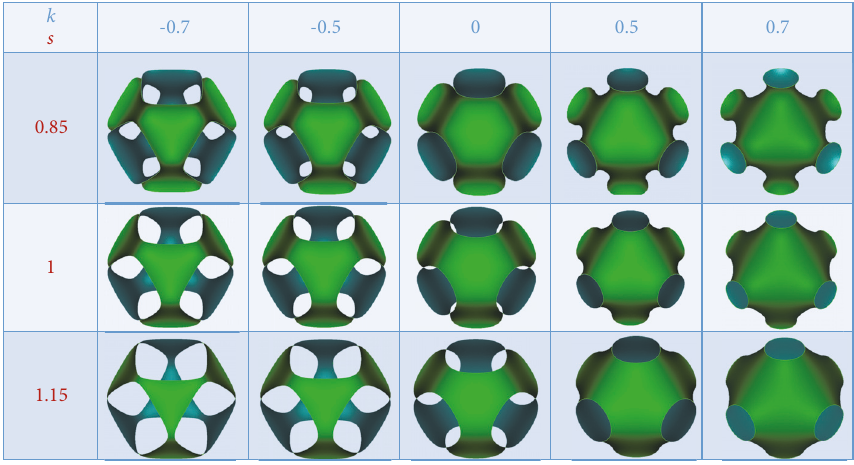
Figure 7: Several geometries of P-cells obtained for different combinations of 𝑘 and 𝑠 parameters.